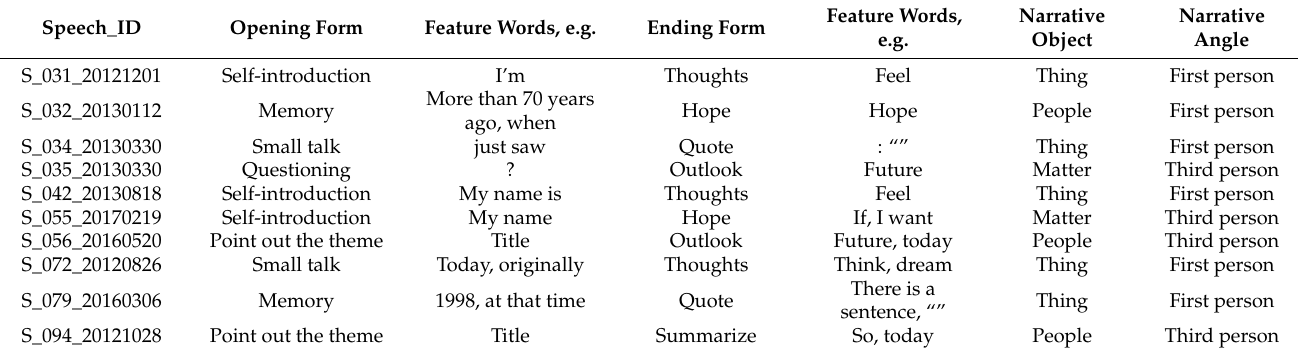
Table 3. Examples of manual labeling format for YiXi